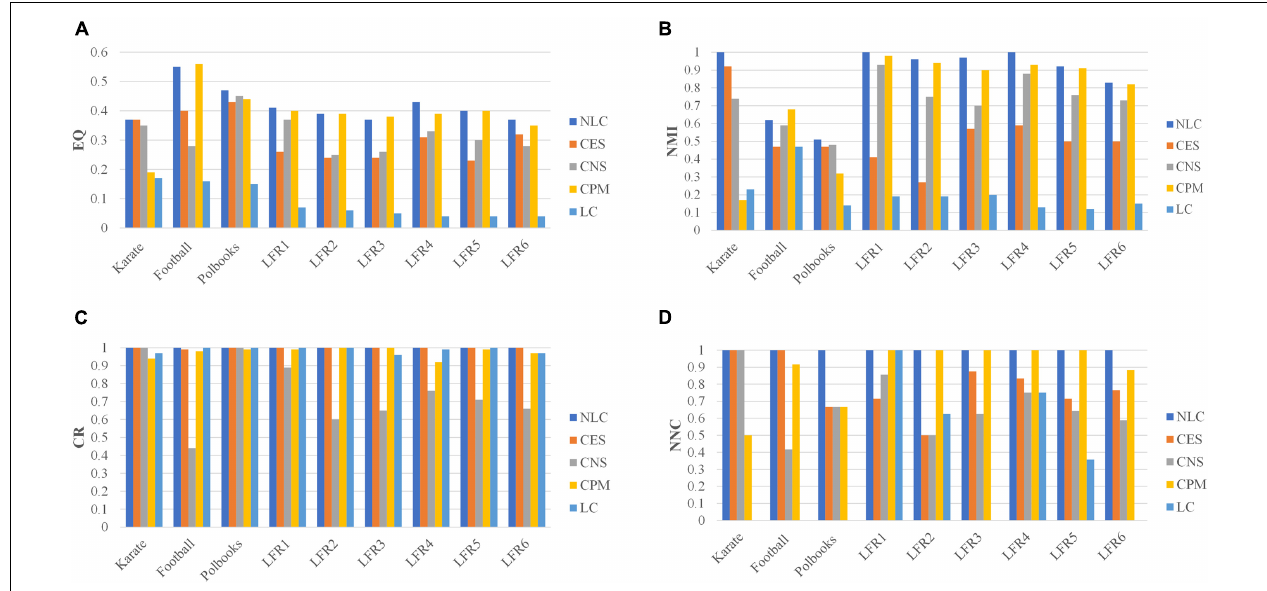
FIGURE 7 | The division results of five algorithms in standard networks and LFR networks including three indicators: (A) EQ, (B) NMI, (C) CR, and (D) NNC.